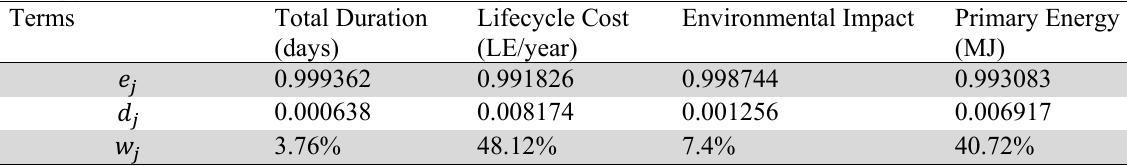
Entropy value, variation coefficient and weight of attributes